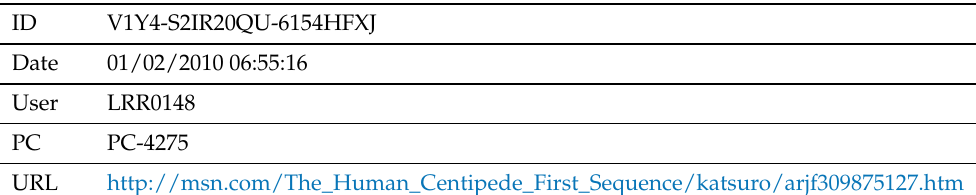
Table 1. A HTTP record in the